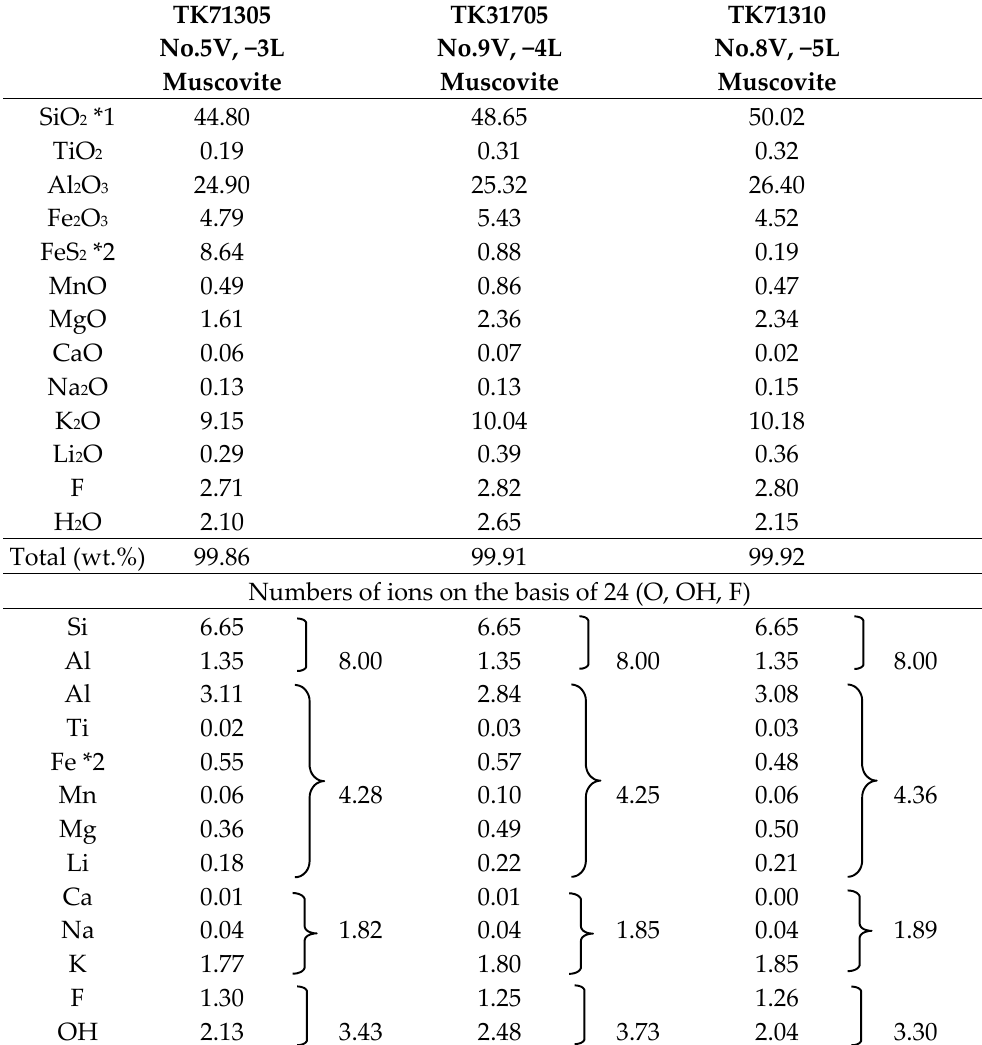
Table 2. Chemical compositions of muscovite from the Takatori veins.